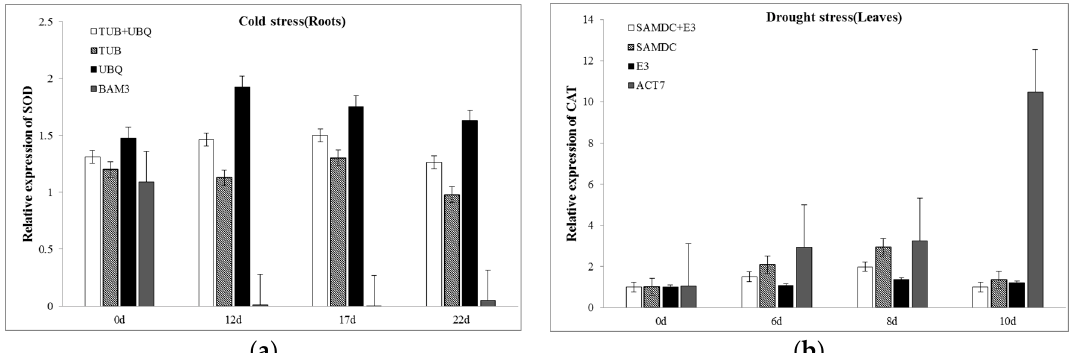
Figure 6. Relative expression levels of target genes. ( a ) Relative expression levels of Cyt-Cu/Zn SOD under cold stress using the two most stable reference genes and the least stable reference gene for normalization in white clover root tissues at different times; ( b ) relative expression levels of CAT under drought stress using the two most stable reference genes and the least stable reference gene for normalization in white clover leaf tissues at different times.